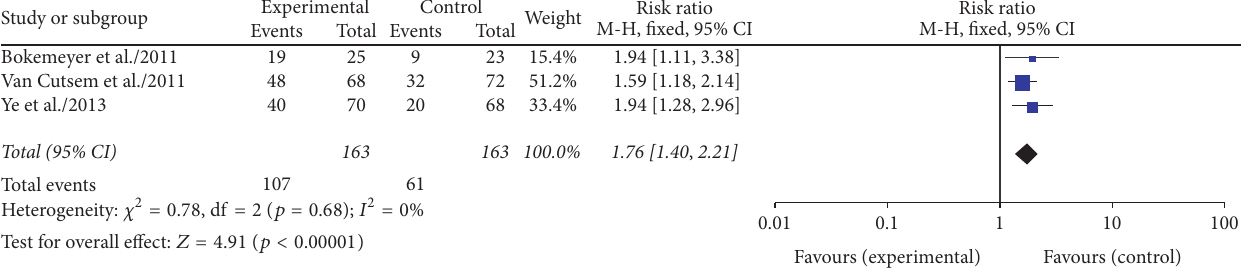
Figure 3: Meta-analysis response rate comparing chemotherapy ± cetuximab in patients with liver-limited metastases.